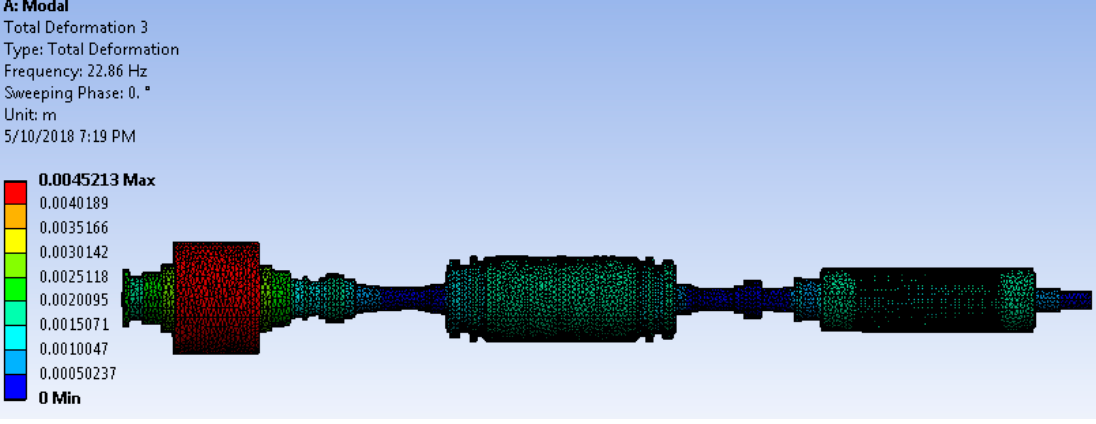
Figure 14. Concept 1 Mode 3 torsional natural frequency and deformation. Energies 2018 , 11 , x FOR PEER REVIEW